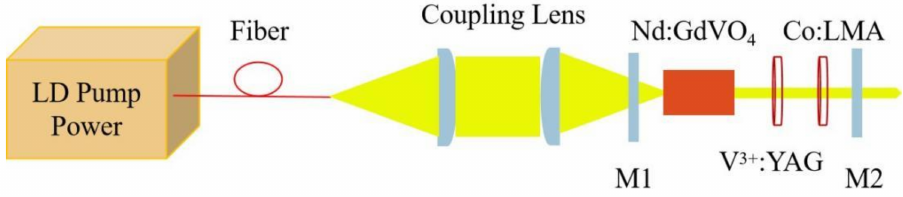
Figure 3. Experimental setup